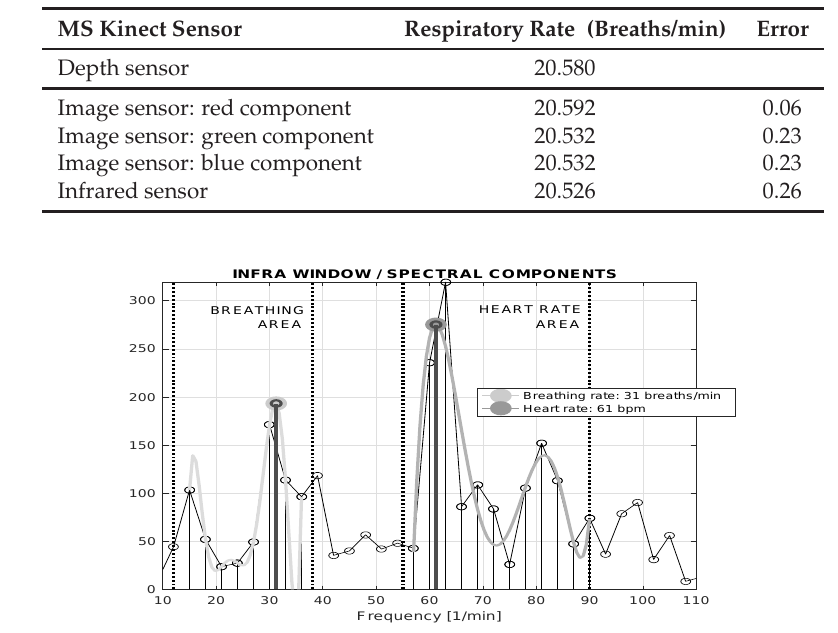
Figure 4. Estimation of the heart rate and breathing frequency from a 20 s infrared video sequence using mean values of the mouth ROI and showing analysis of spectral components in frequency ranges of breathing and heart rate, with extreme values detected by a local polynomial